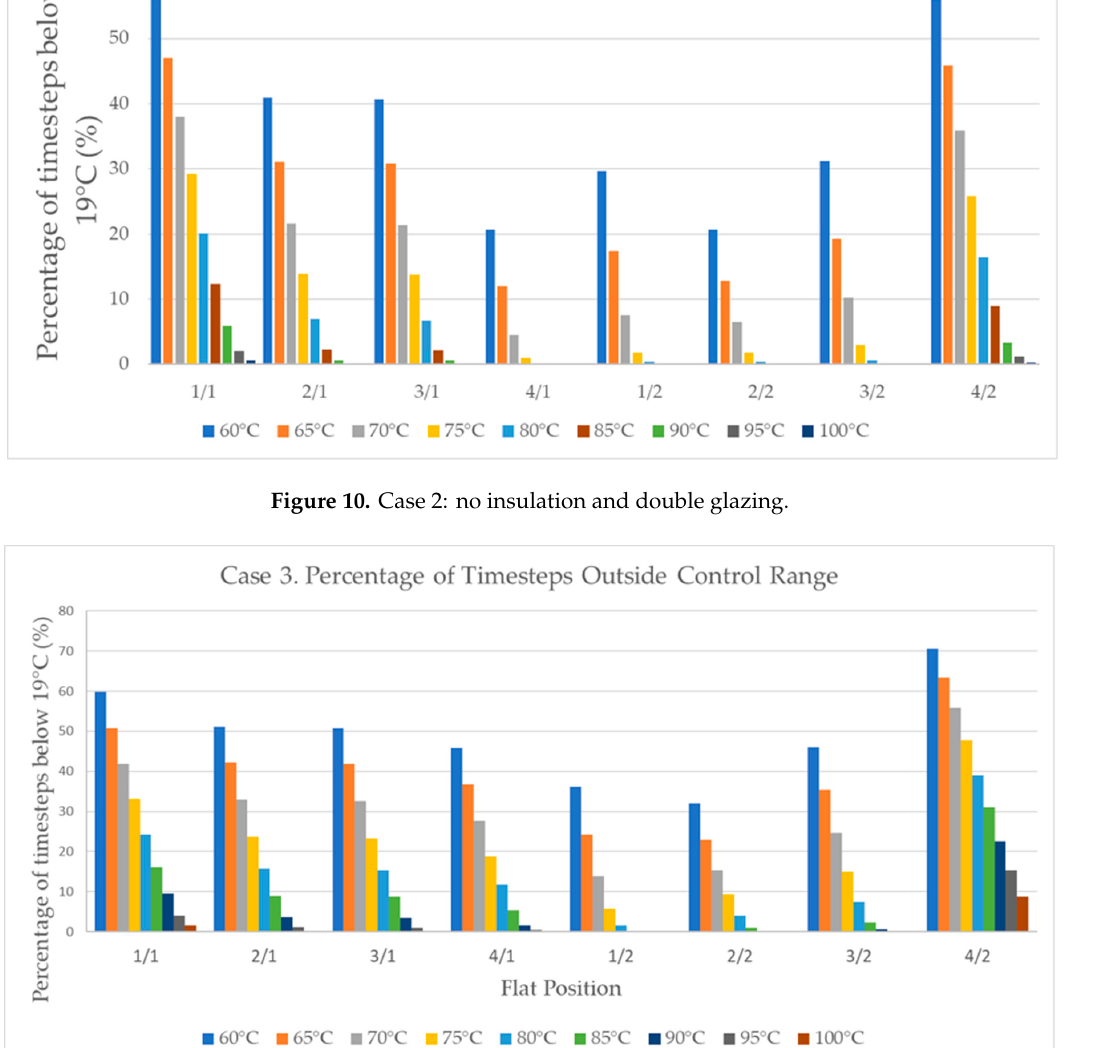
Figure 11. Case 3: insulation with single glazing.